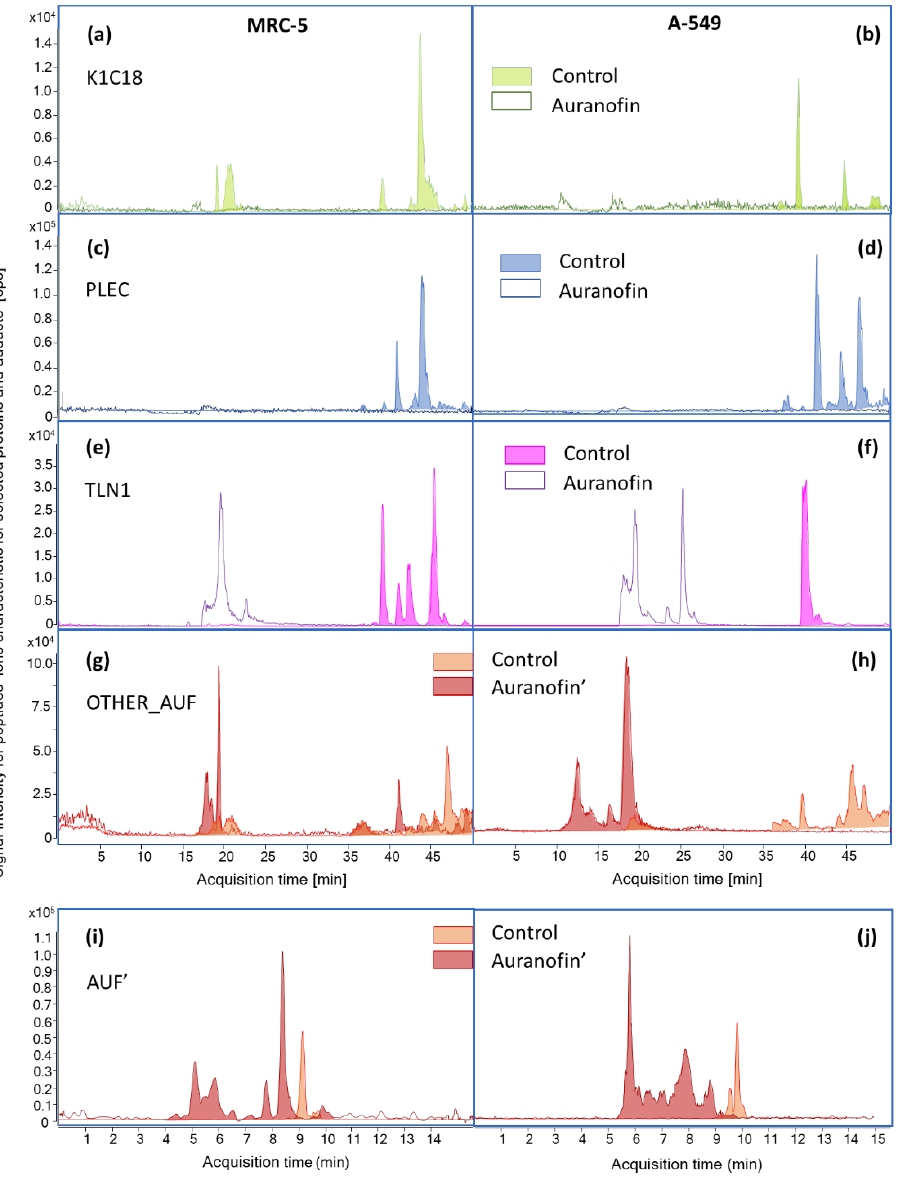
Figure 5. Extracted ion chromatograms ( µ RPLC-ESI-MS, A-H) for at least three peptides (summed EICs) obtained for selected proteins with proposed identities for MRC-5 ( a , c , e ) and A-549 ( b , d , f ) cells in control group and exposed to auranofin. Extracted chromatograms and electropherograms ( µ RPLC-ESI-MS, ( g , h ) and CZE-ESI-MS, ( i , j )) for six signals found in MRC-5 and A-549 cells after exposure to